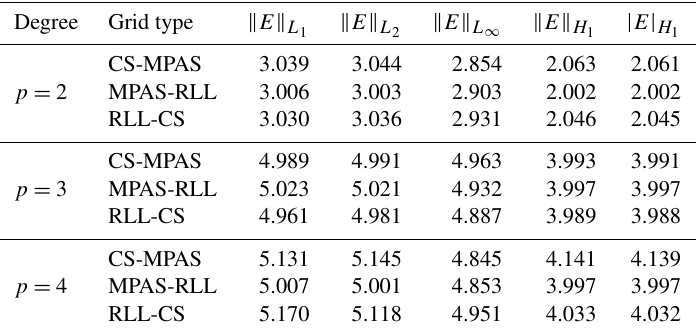
Table 5. WLS-ENOR: convergence rates for the A NALYTICAL F UN 1 field on all mesh types. Degree